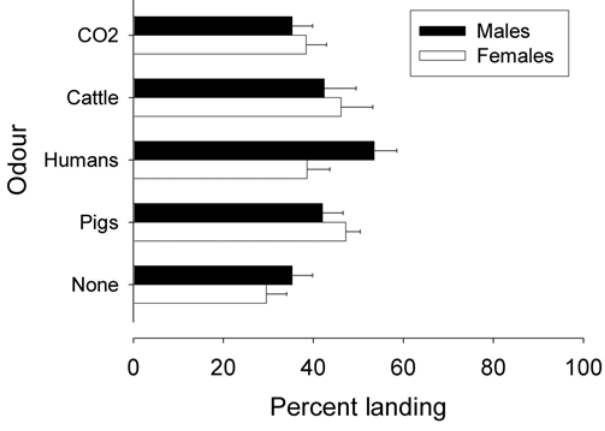
Figure 2. Landing response of G.f.quanzensis on an E-target baited with natural host odours or carbon dioxide dispensed inside a tent. The landing response is the number of tsetse caught landing on the target expressed as a percentage of the total (landing + circling) catch.